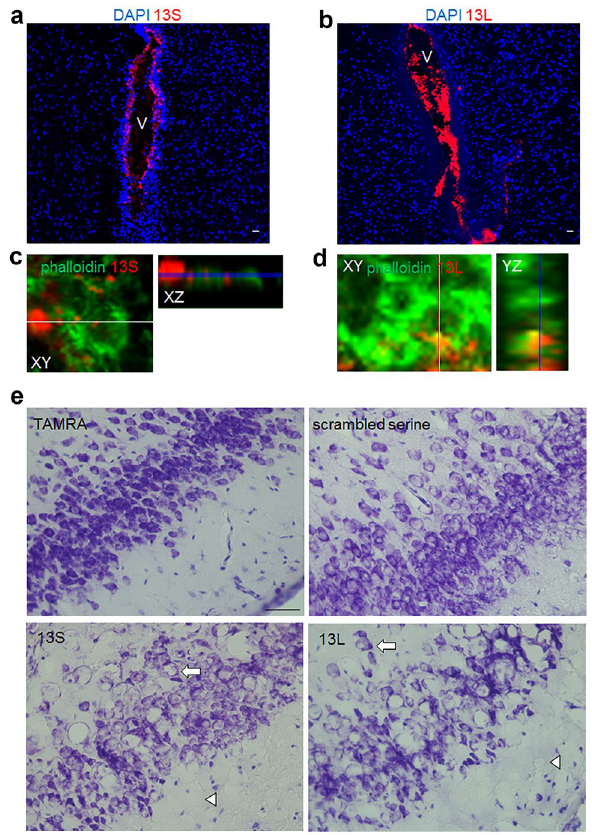
Figure 5. Vacuolar degeneration of the brain given 13S and 13L aggregates. ( a – d ) Fluorescence images of coronal brain sections of mice to which aggregated 13S (red) ( a , c ) or 13L (red) ( b , d ) was injected into the lateral ventricle 1 day before. The sections were stained with phalloidin (green) and DAPI (blue). The 13S ( a ) and 13L ( b ) signals are found in the lateral ventricle (V). Ortho XZ or YZ-axis cross section confocal images along the white line in the XY-axis view proved localization of 13S ( c ) and 13L ( d ) in the phalloidin-positive cytoplasm. ( e ) Nissl-stained coronal sections of mice treated with TAMRA, scrambled serine, 13S or 13L. Images were taken from the piriform cortex. The arrows and arrowheads indicate vacuoles inside and outside the soma of neurons, respectively. Scale bars, 20 µm ( a , b ), 50 µm ( e